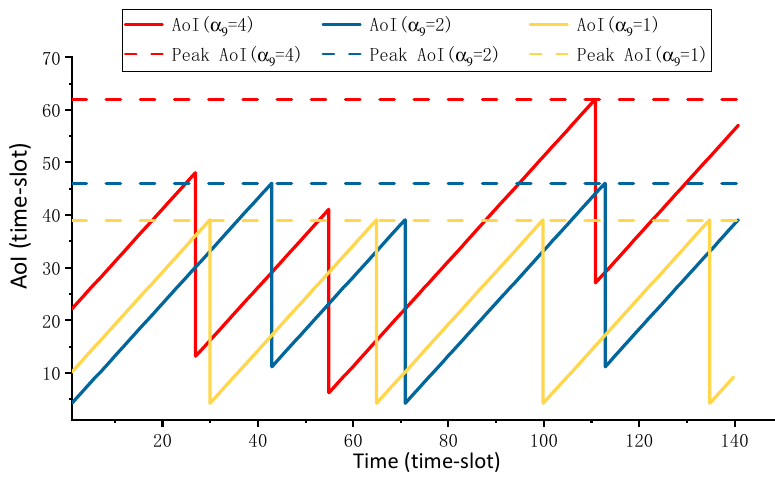
Figure 6. The AoI of node #9 with different α 9 . The boxplot of the AoI for node #9 with di ff erent 𝛼 (cid:2877) is shown in Figure 7, which indicates that reducing the TIC 𝛼 (cid:2877) leads to a decrease in the peak AoI, while the average AoI of the node also decreases accordingly.